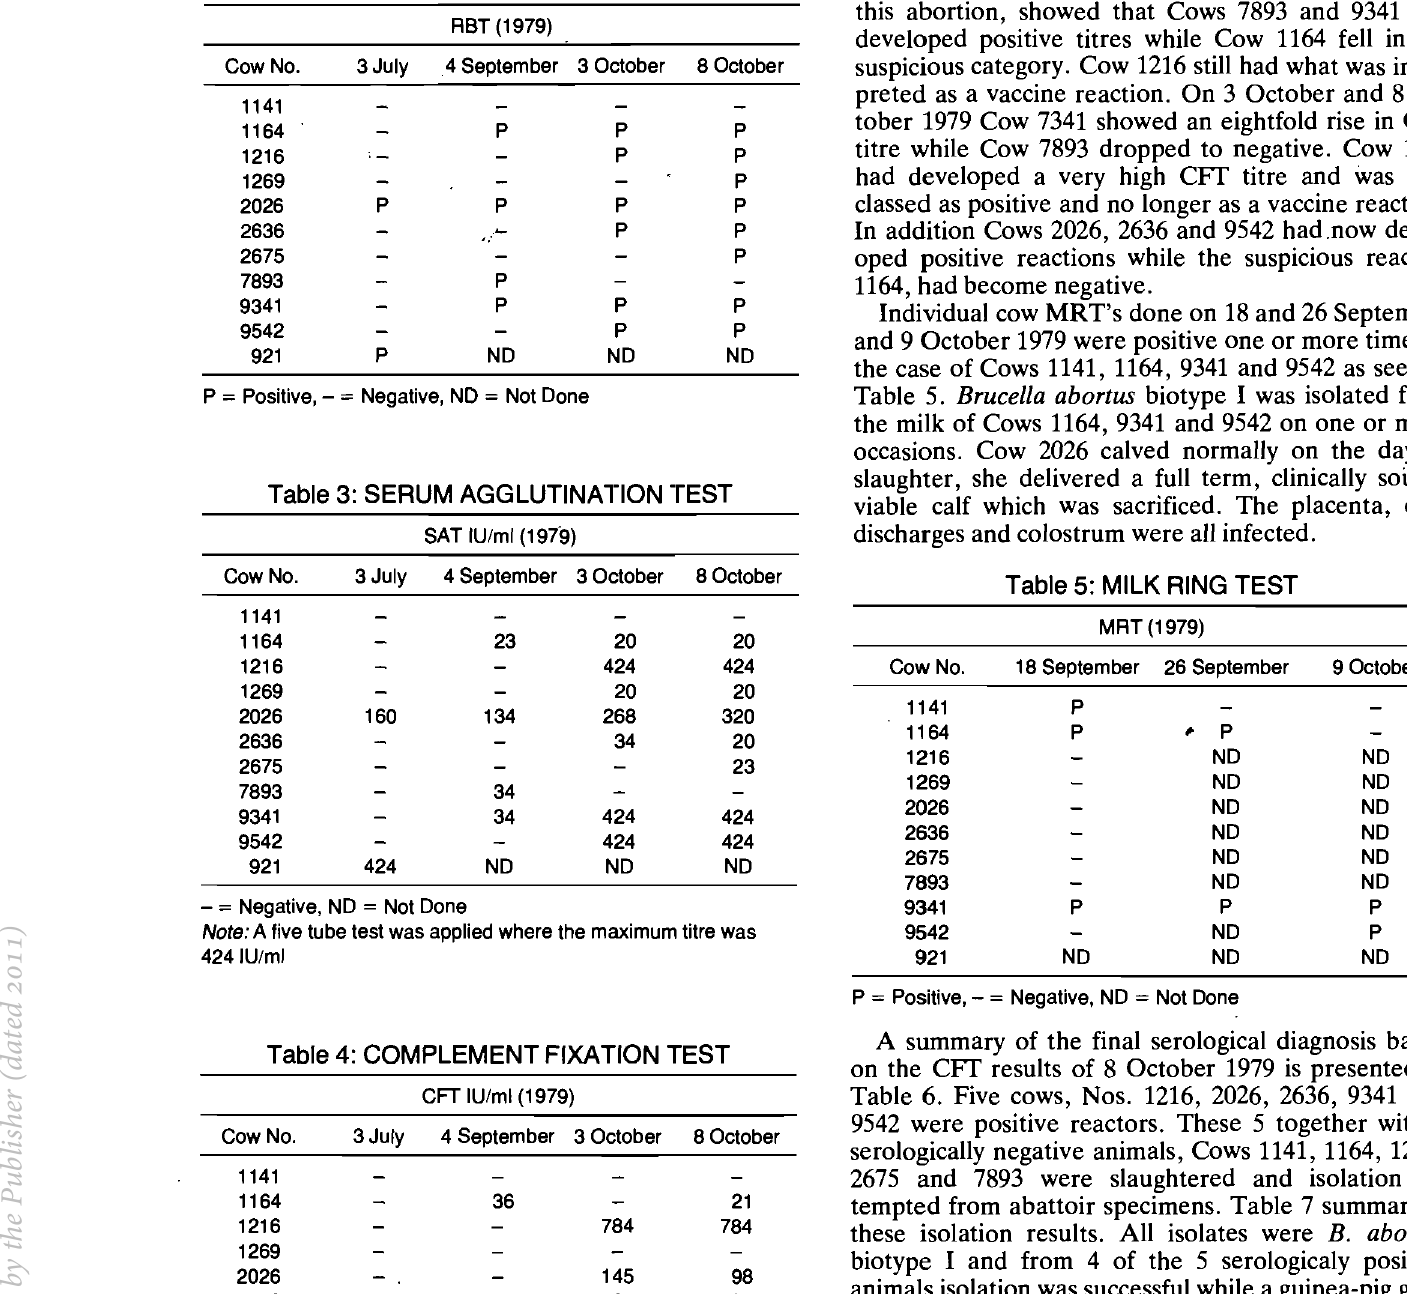
Table 2: ROSE BENGAL TEST